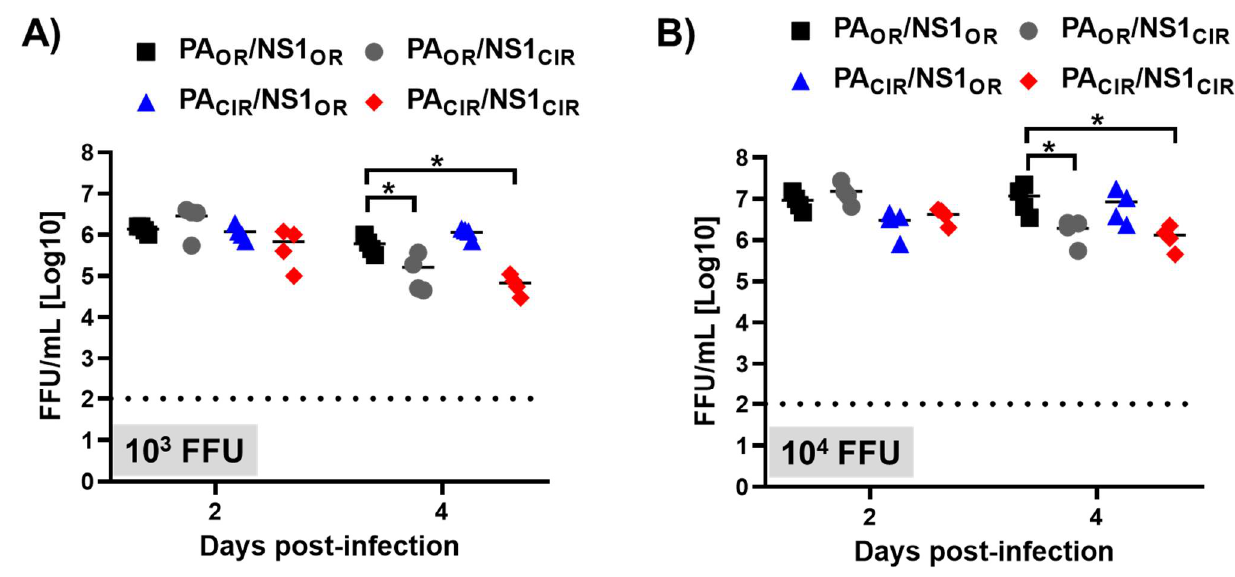
Figure 7. Viral titers of recombinant viruses containing amino acid changes in H5N1 NS1 and PA proteins: Groups of 7-to-8-week-old A129 male mice ( N = 8/group) were infected with 1000 (10 3 ; A ) or 10,000 (10 4 ; B ) FFU/mouse of the indicated viruses (PA OR /NS1 OR , PA OR /NS1 CIR , PA CIR /NS1 OR , and PA CIR /NS1 CIR ). Mice were sacrificed at 2 ( N = 4) and 4 ( N = 4) d p.i, and right lungs were harvested, homogenized, and used to quantify viral titers by immunofocus assay (FFU/mL. *, p < 0.05 (PA OR /NS1 OR vs. PA OR /NS1 CIR , PA CIR /NS1 OR , and PA CIR /NS1 CIR ) using 2-way ANOVA ( N = 4 per time point). Non-significant when p > 0.05.